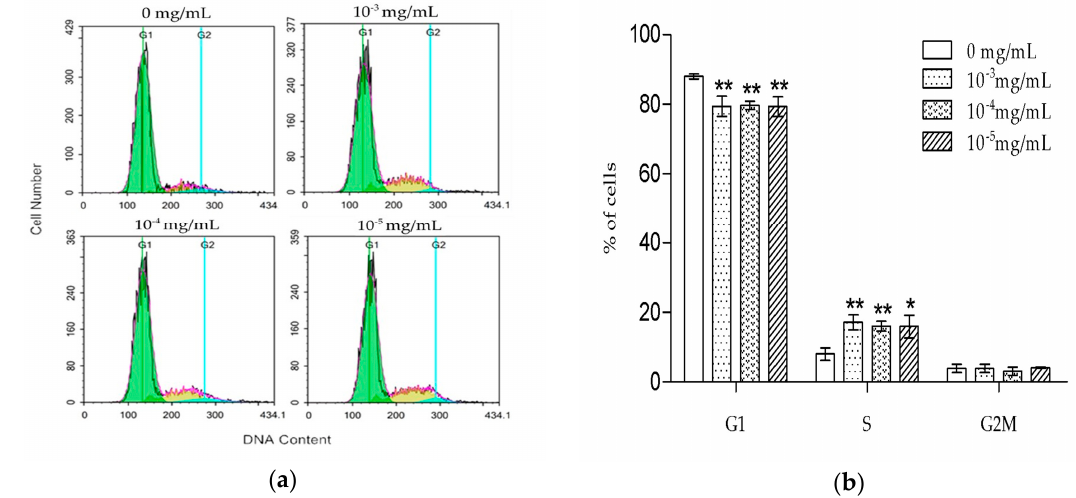
Figure 3. Effect of TSG on ( a ) the DNA content and ( b ) the cell cycle distribution of MC3T3-E1 cells. Data are represented as the mean ± SD of three determinations. * p < 0.05 and ** p < 0.01 when compared with the control group.